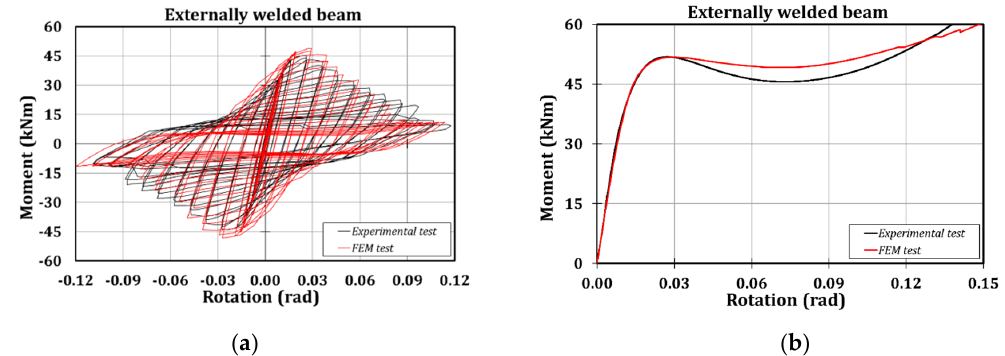
Figure 11. Experimental versus FE results: cyclic test ( a ) and monotonic test ( b ).